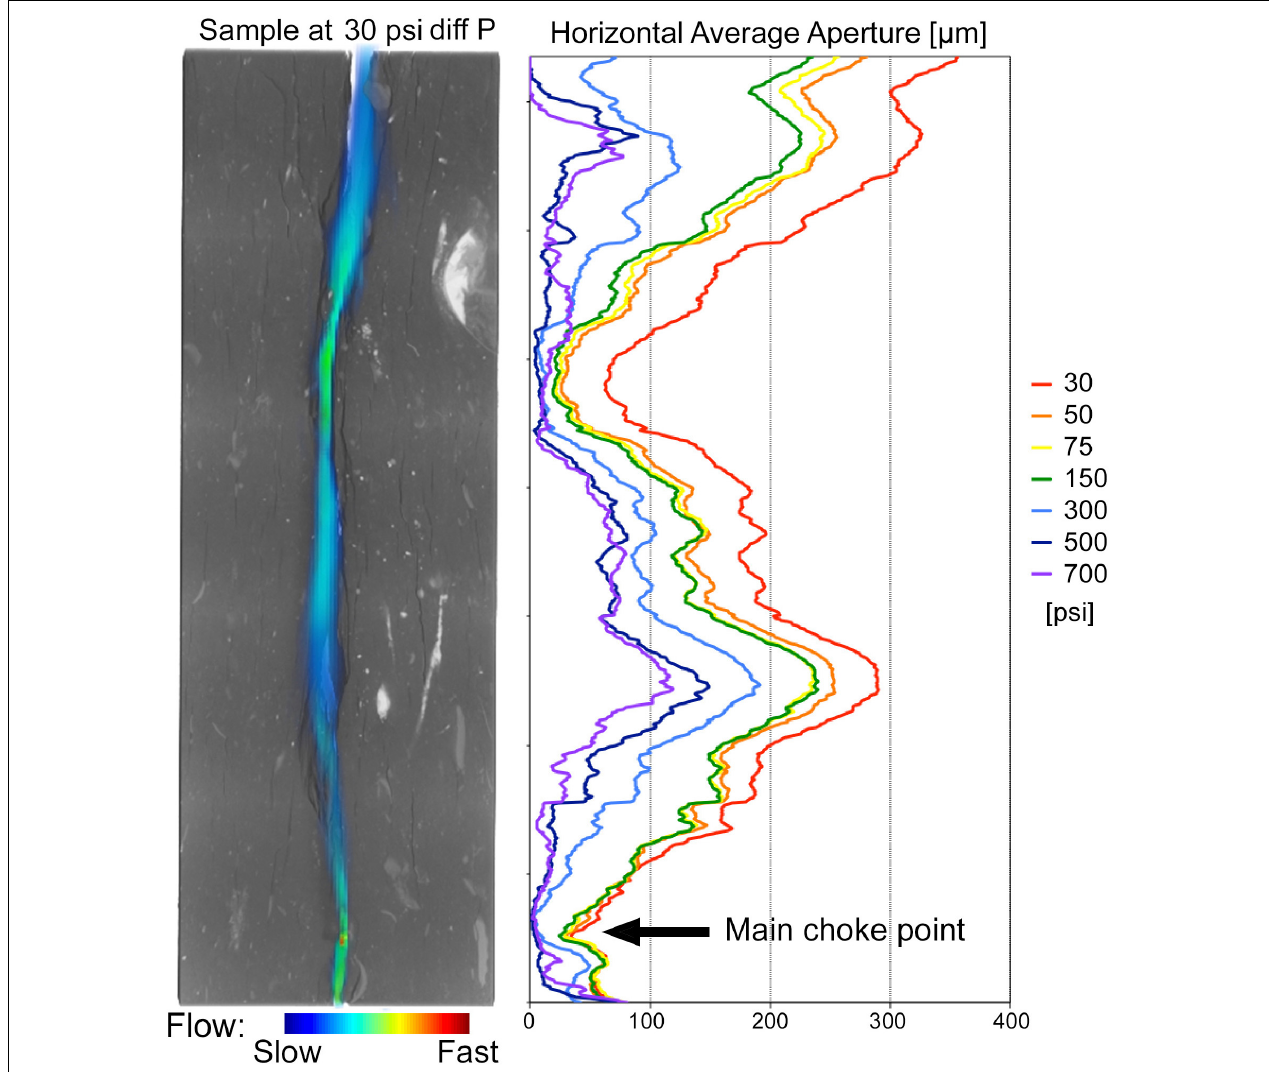
FIGURE 5 | Average aperture distributions along the vertical axis of the sample during the flow experiment. On the left, a vertical section of the sample at the beginning of the flow, with superimposed in colors the Stokes flow velocity field calculated for the fracture at that